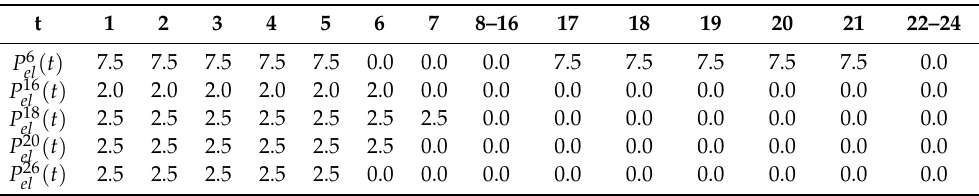
Table 8. Optimal demand response (MW) in a day.